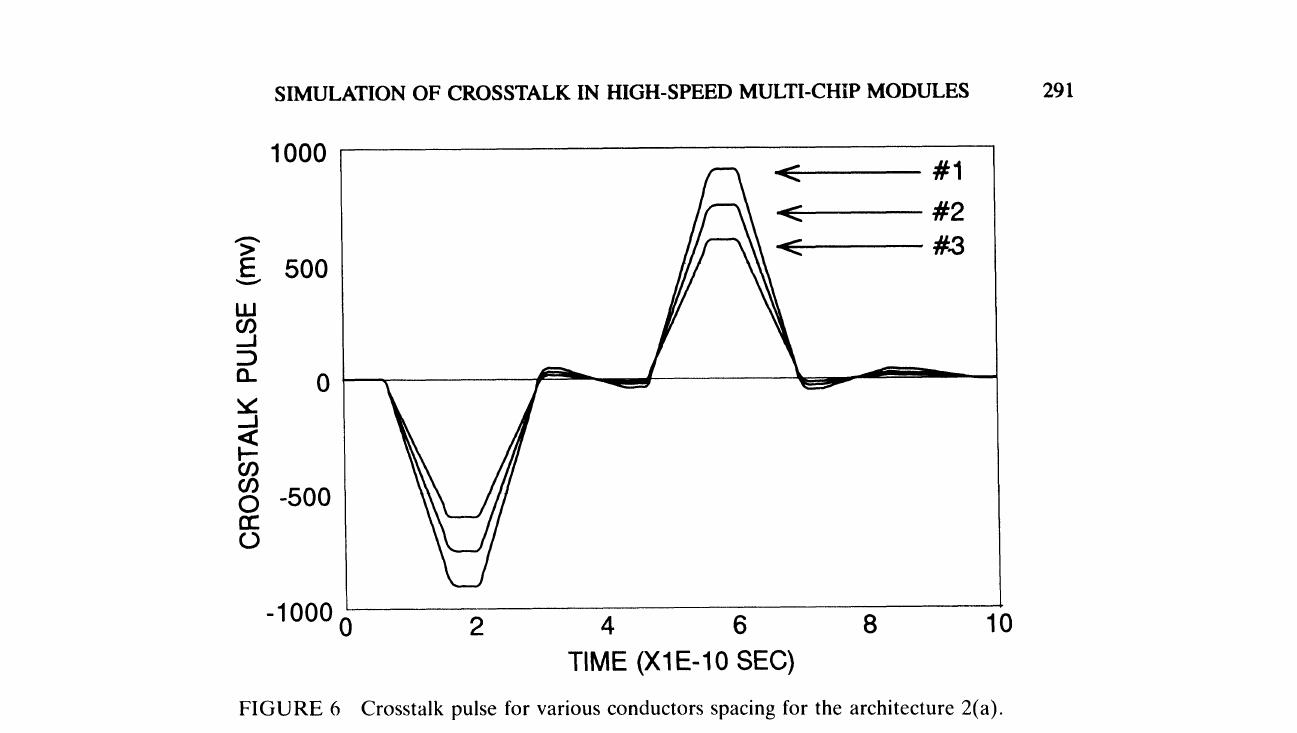
2 4 6 8 10 TIME (Xl E- 10 SEC) FIGURE 6 Crosstalk pulse for various conductors spacing for the architecture 2(a).